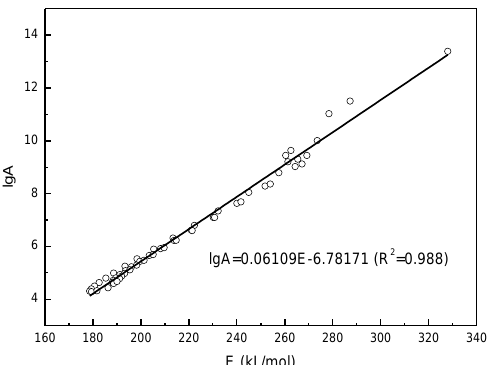
Figure 6. The activation energy estimated using the integral isoconversional model of Miura–Maki for coal sample with different particle sizes.